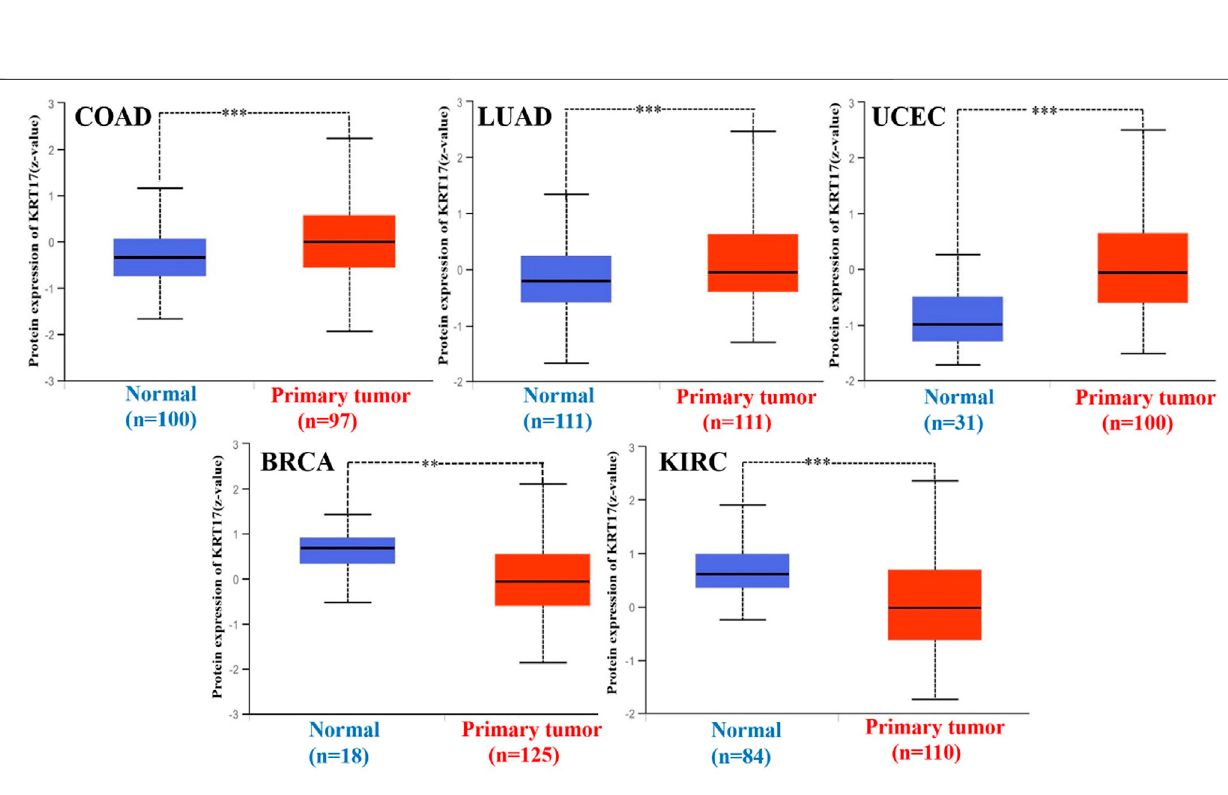
FIGURE 1 | Expression status of KRT17 in various malignant tumors was analyzed through TIMER2; the fi gure showed that KRT17 expression in most malignant tumor tissues was higher than that in normal tissues, and it was statistically signi fi cant ( p p < 0.05; pp p < 0.01; ppp p < 0.001) (TCGA dataset).